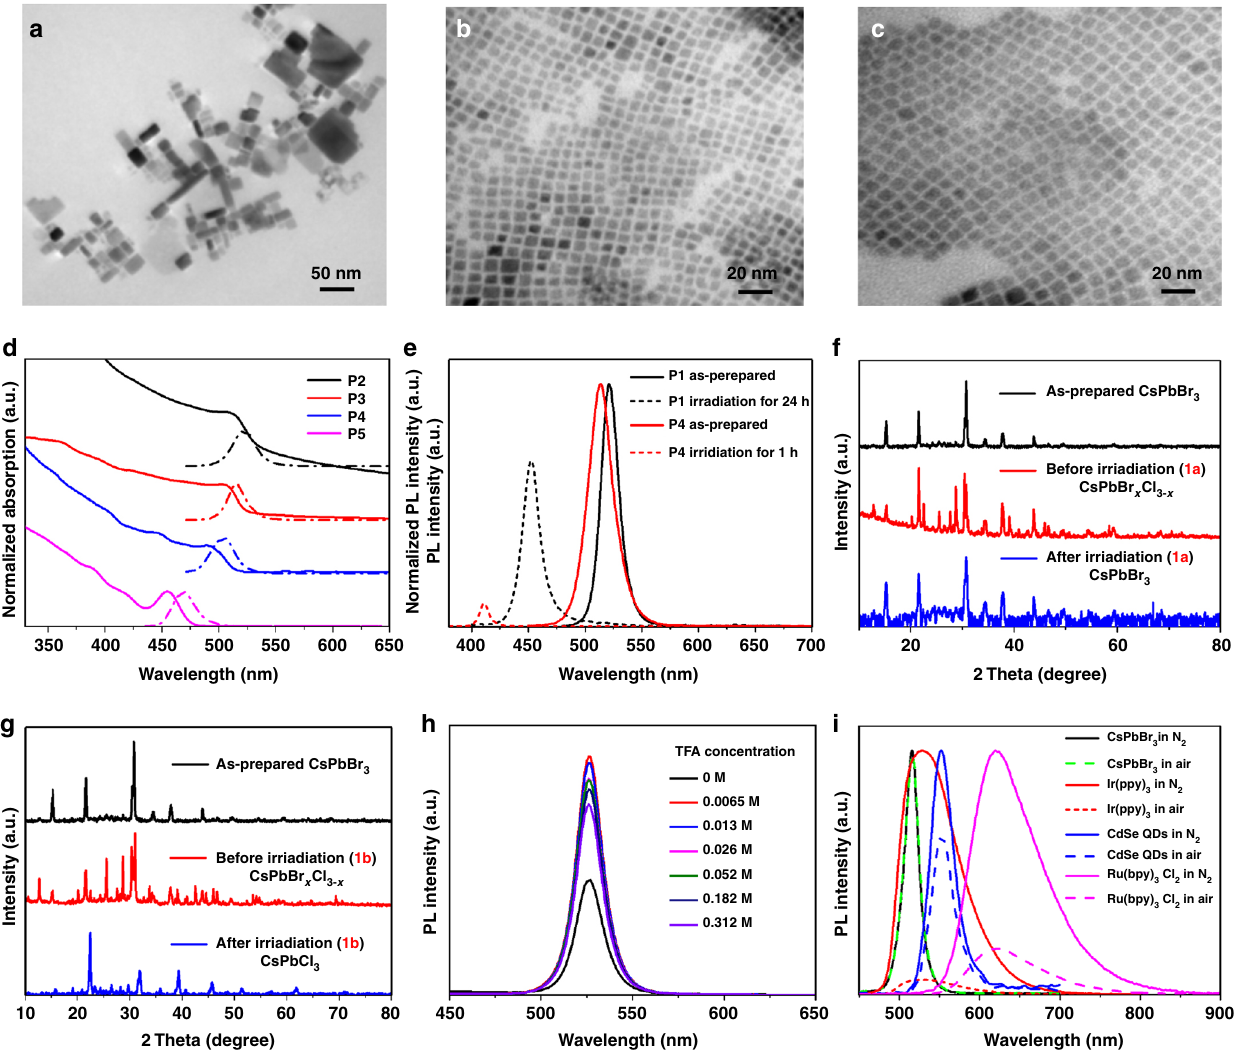
Fig. 2 Characterization and spectroscopy studies of photocatalysts. a TEM of CsPbBr 3 P1 ; b P3 ; c P4 ; d UV-vis and PL spectra of CsPbBr 3 P2 – P5 ; e PL spectra for P1 and P4 in CH 2 Cl 2 as prepared and after LED irradiation for 24 h and 1 h, respectively. f XRD of as-prepared CsPbBr 3 P1 ; isolated from the reaction 1a before and after irradiation, respectively; g the corresponding XRD for reaction 1b ; h PL spectra of P1 in THF with addition of TFA; i PL spectra of CsPbBr 3 NCs, Ir(ppy) 3 , CdSe QDs and Ru(bpy) 3 Cl 2 in air or N 2 -saturated solutions. Source data are provided as a Source Data fi